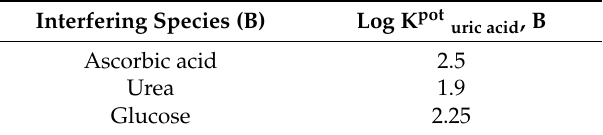
Table 3. The calculated selectivity coefficients for the interfering species using separate solution method using 0.1 mM solution of each interfering